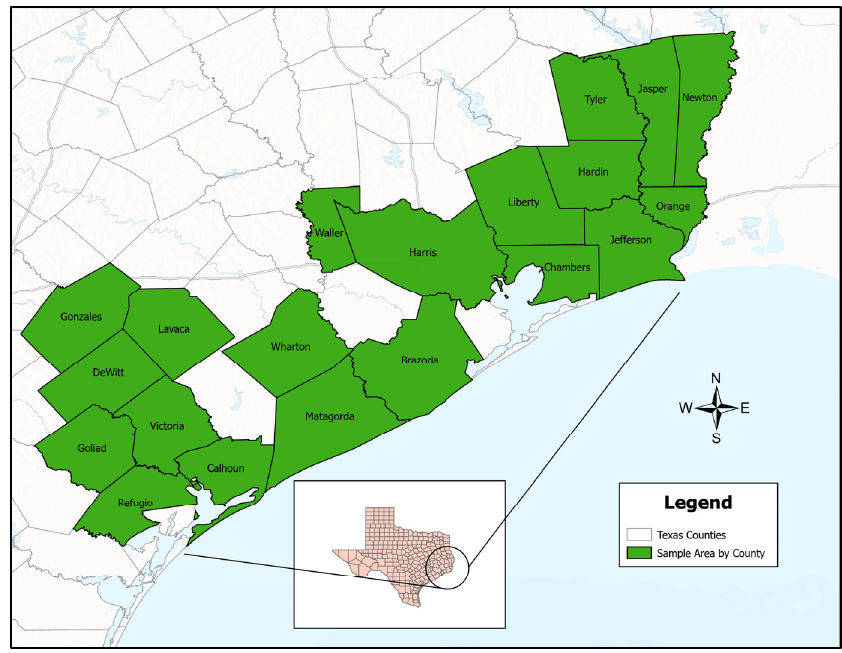
Figure 1. Texas counties with well users that chose to voluntarily participate in the post-flood well water sampling campaigns.